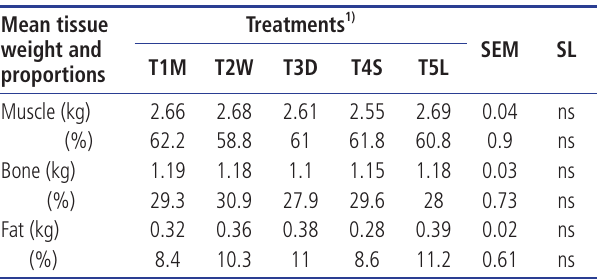
Table 6. Mean tissue weight and proportions from five primal carcass cuts (right half) of carcass from Arsi-Bale sheep fed diets containing different varieties of faba bean straw (70%) and concentrate (30%) Mean tissue weight and